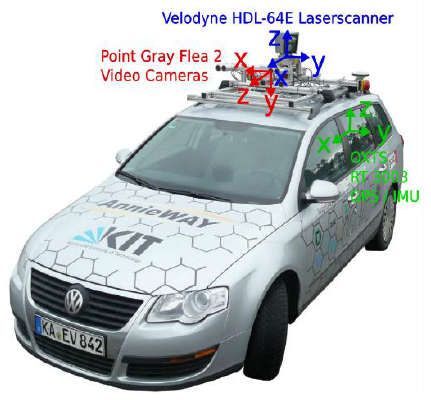
Figure 6. The sensor configuration on the platform (courtesy of [25,26]).